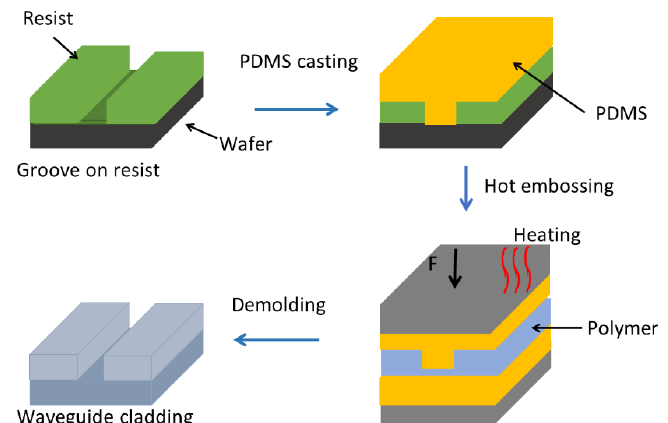
Figure 2. Schematic representation of the fabrication process of the waveguide cladding on poly- mer, showing intermediate